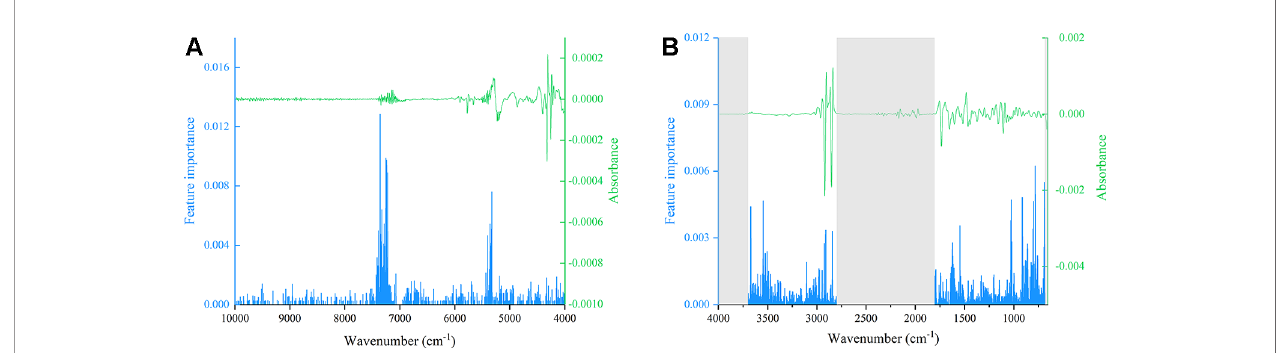
FIGURE 11 | The permutation accuracy importance of each variable of spectra (A) : MSC+SD FT-NIR; (B) :